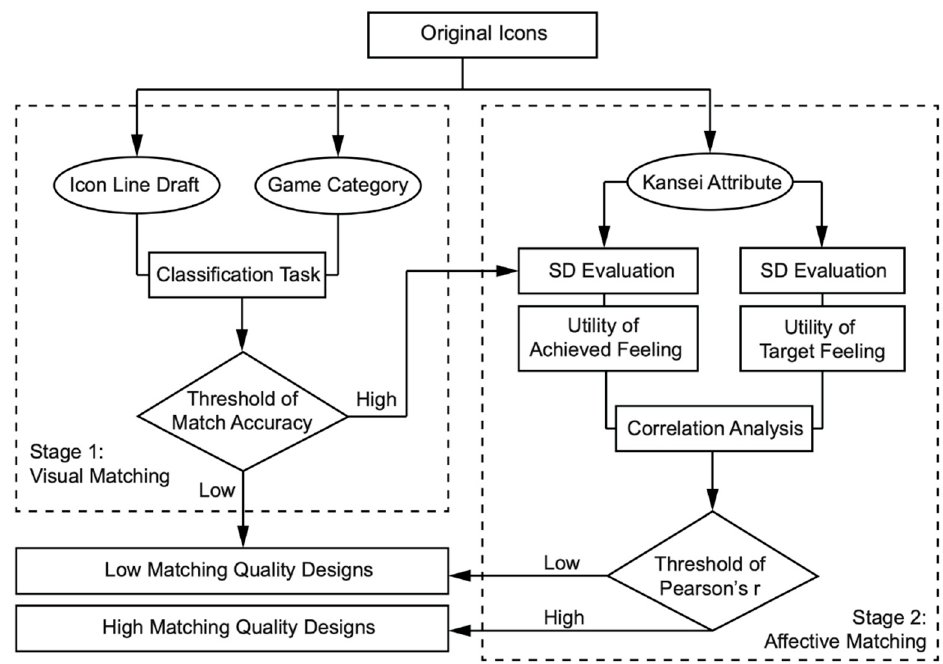
Figure 1. Study Figure 1. Study process.